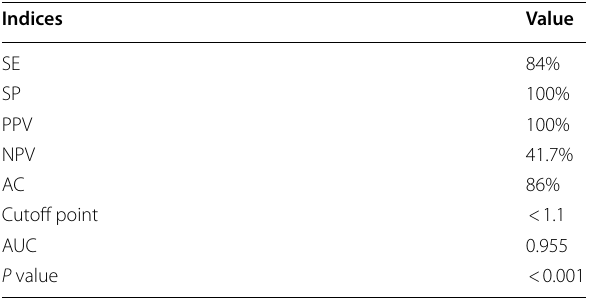
Table 12 Accuracy of ADC in prediction of active tract among studied